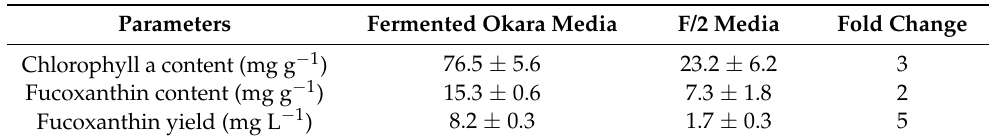
Table 2. Chlorophyll and fucoxanthin quantification in P. tricornutum cells from fermented okara media and F/2